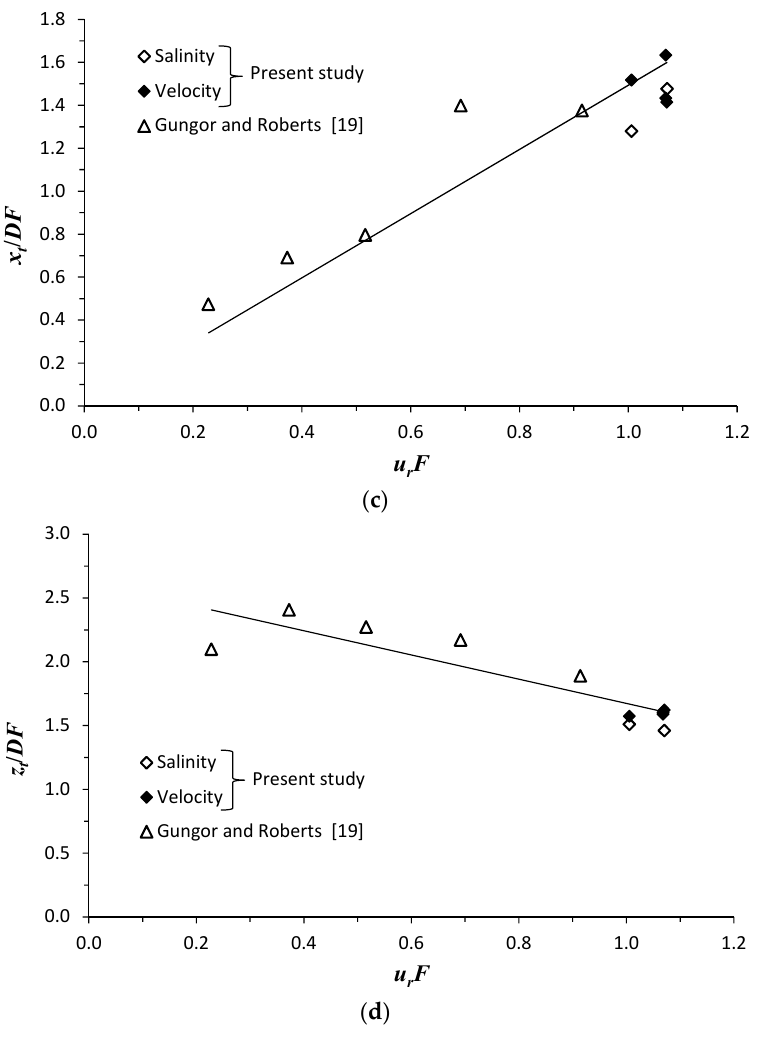
Figure 7. Jet trajectory analysis: ( a ) scaling of jet trajectories based on the characteristic length scales x i , x t and z t . The solid red curve represents the solution of Equation (15); ( b ) x i / DF versus u r F ; ( c ) x t / DF versus u r F ; ( d ) z t / DF versus u r F . The solid regression lines on ( b – d ) refer to the data of jet concentration of the present study and that of Gungor and Roberts [19].